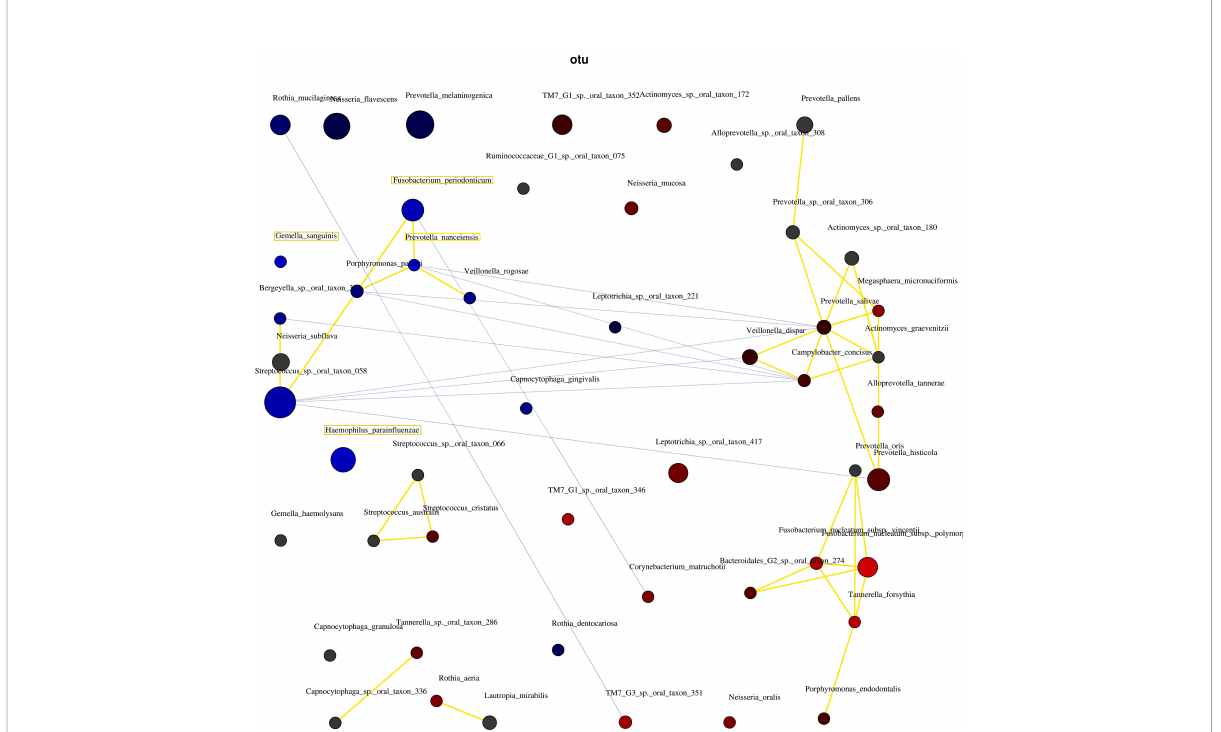
FIGURE 5 The interaction of bacteria using network analysis. Taxa and explanatory variables are represented as nodes, taxa abundance as node size, and edges as positive and negative associations. The networks were generated using Spearman ’ s rho. The nodes of positively or negatively correlated taxa are connected with yellow and blue edges, respectively. The blue and red nodes indicate the bacteria related to the non-severe and severe groups, respectively. Positive and negative correlations as edges are indicated by yellow and blue lines,